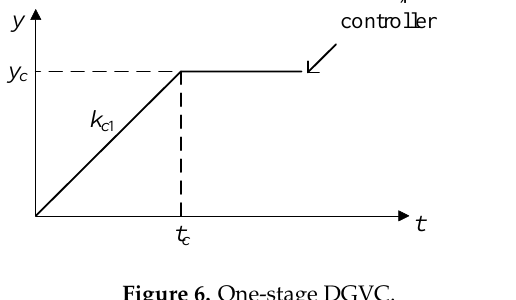
Figure 6. One ‐ stage DGVC.